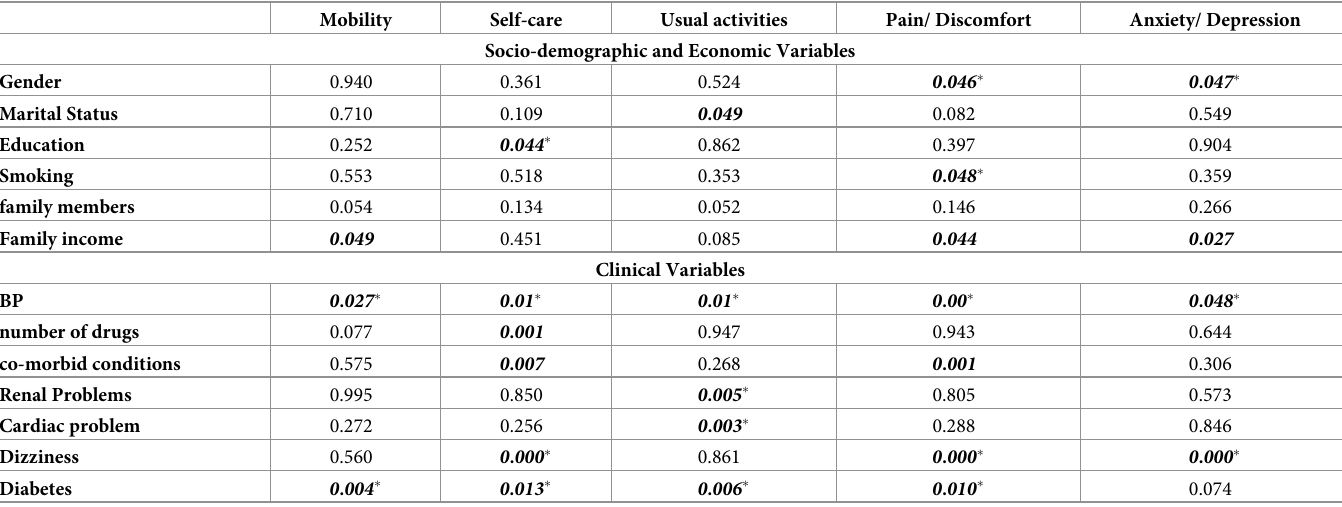
The table represents only those SDECV who have significant association with at least one of the five domains of EQ 5D 5L. � significant